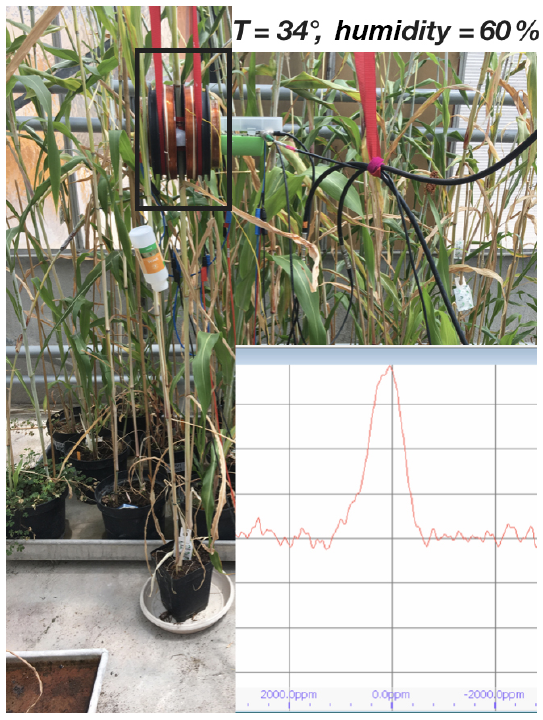
Figure 6. NMR spectrum of a sorghum plant at 333kHz by the SHS 4 coils prototype in a greenhouse at CIRAD.